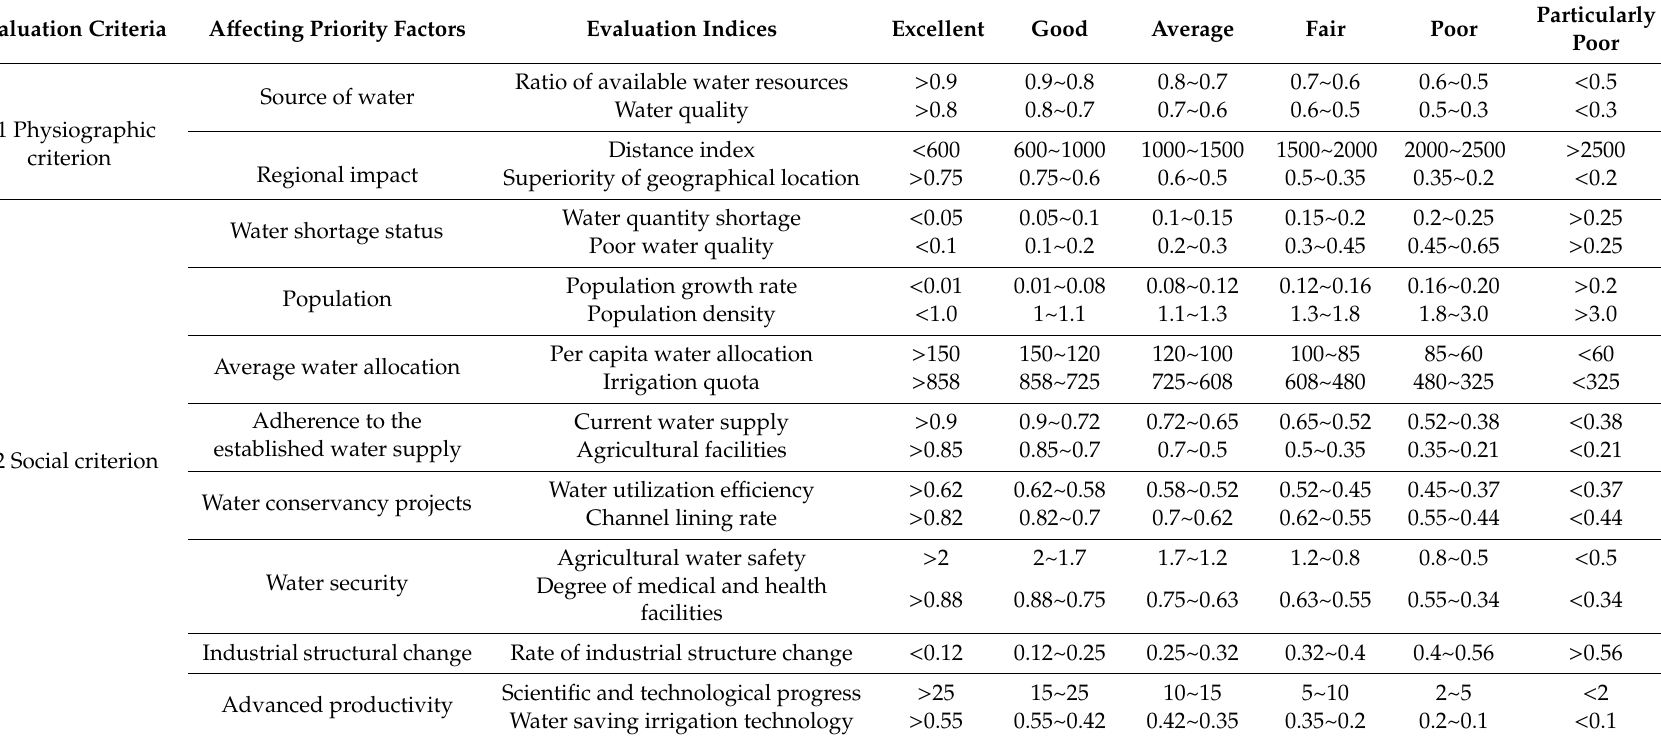
Table A1. The classification standard of membership degree of evaluation